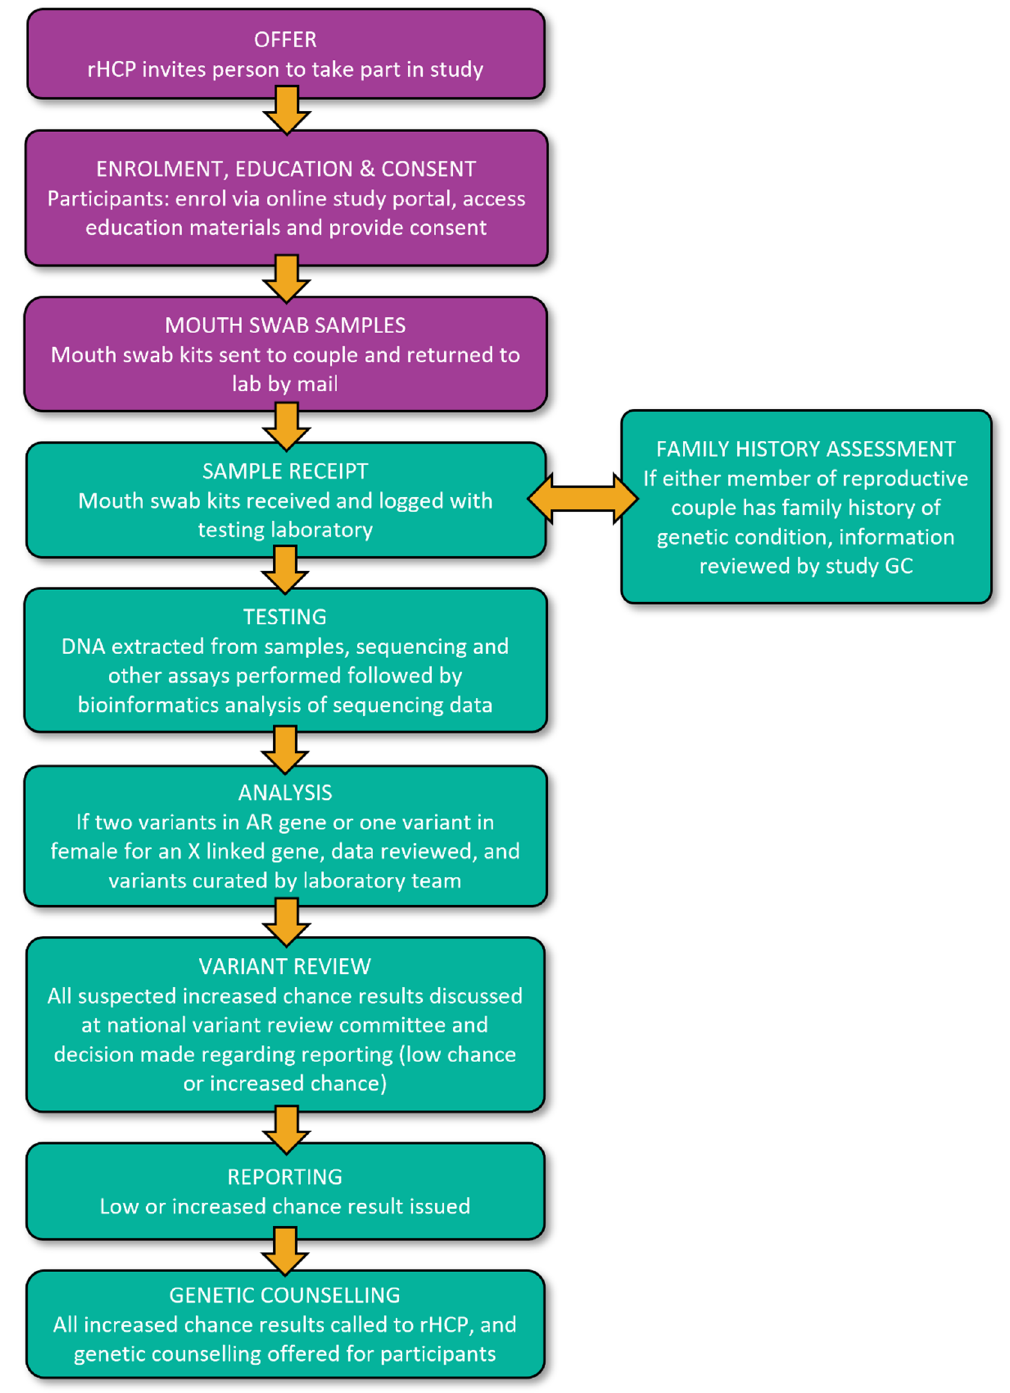
Figure 4. Laboratory testing and management of results in the Mackenzie’s Mission study.